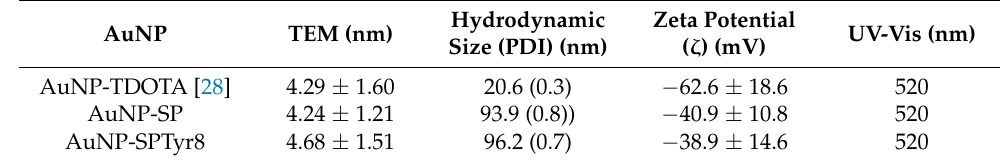
Table 1. Physico-chemical characteristics * of AuNP-TDOTA, AuNP-SP and AuNP-SPTyr8